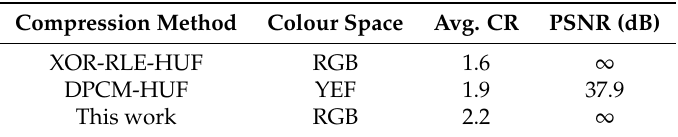
Table 3. Compression performance of different algorithms in software evaluation. XOR-RLE-HUF means and finally Huffman is applied. DCPM-HUF means DPCM encoding is applied in every colour plane, and next Huffman encoding is